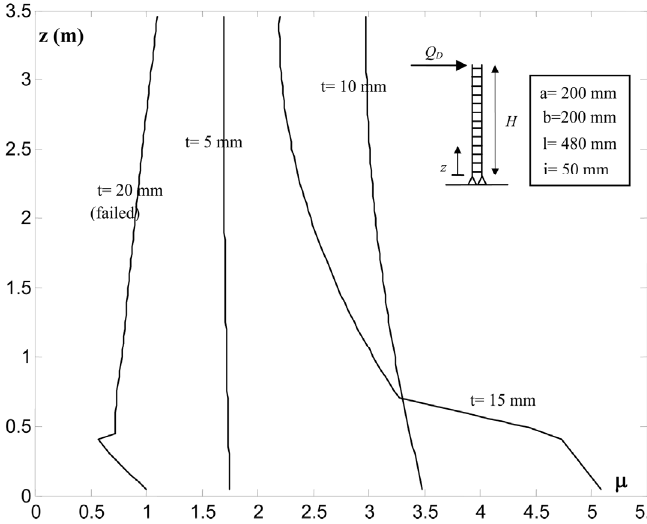
Figure 10. Model A: Displacement ductility requirements for steel plates at the last step. With reference to model B, with eccentricity, the pushover curves for different X-plate thickness and eccentricity values, are shown in Figure 11a–c.